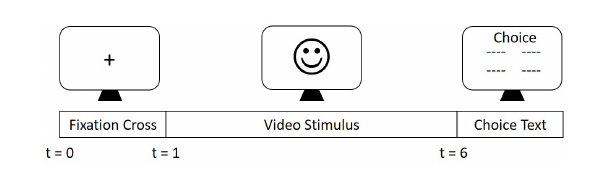
FIGURE1 Experiment Procedure. Experimental stimuli derived from the Cambridge Mind Reading Face-Voice Battery were presented in a randomized order. Each trial consisted of a fixation cross presented in the center of the screen for 1 s. A stimulus video was then displayed for 5 s. Following the presentation of the stimulus, four word options were presented. Participants were then required to choose one of these four options, using a keyboard, that corresponded to the correct emotion that was portrayed by the